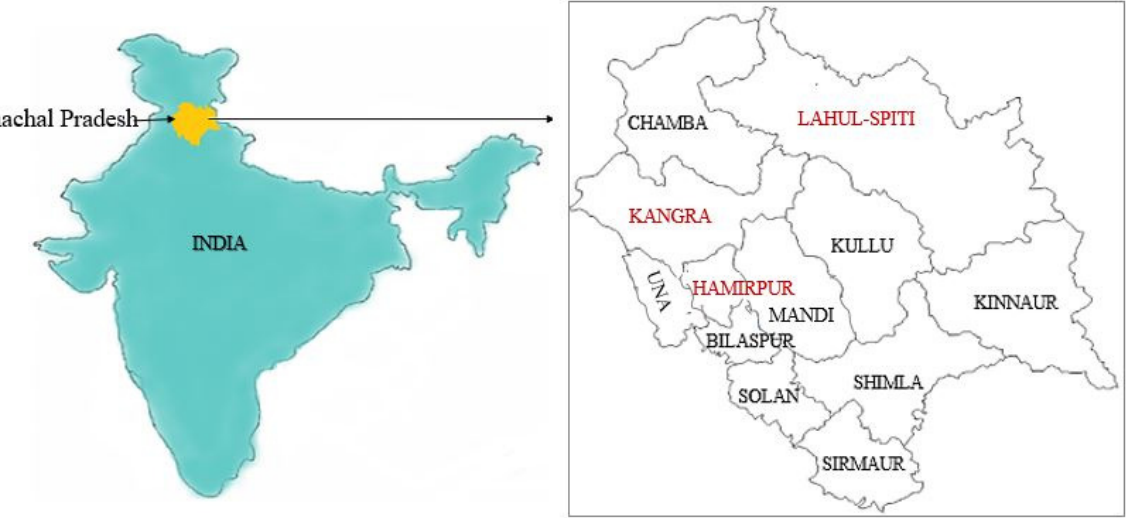
Figure 3. Map of India, showing districts of Himachal Pradesh (district names are added in red font where maximum number of medicinal plants were reported for jaundice treatment).